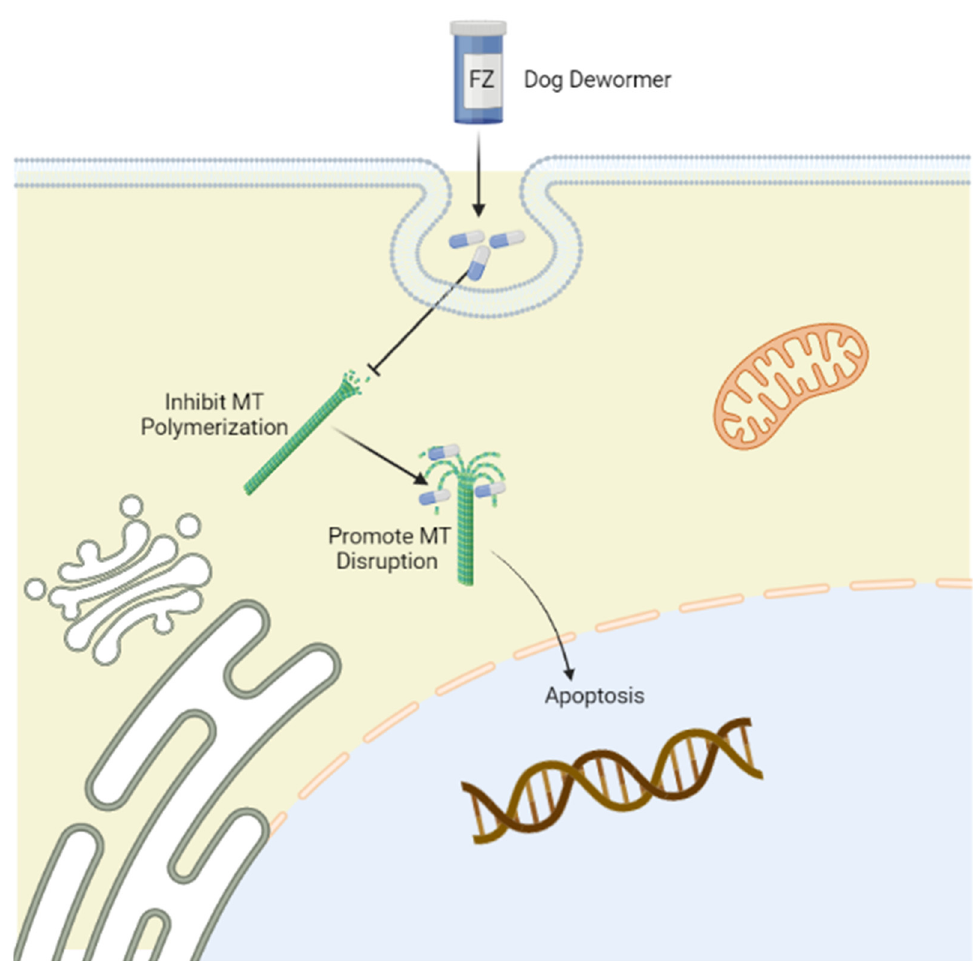
Figure 1. Mechanism of action of fenbendazole (FZ) targeting tubulin. Tubulin is the leading molec- ular target of FZ, which selectively binds to the β -tubulin of microtubules to disrupt microtubular polymerization, promoting immobilization and the death of parasites. The figure was created using Biorender (https://biorender.com/) (accessed on 15 May 2022).